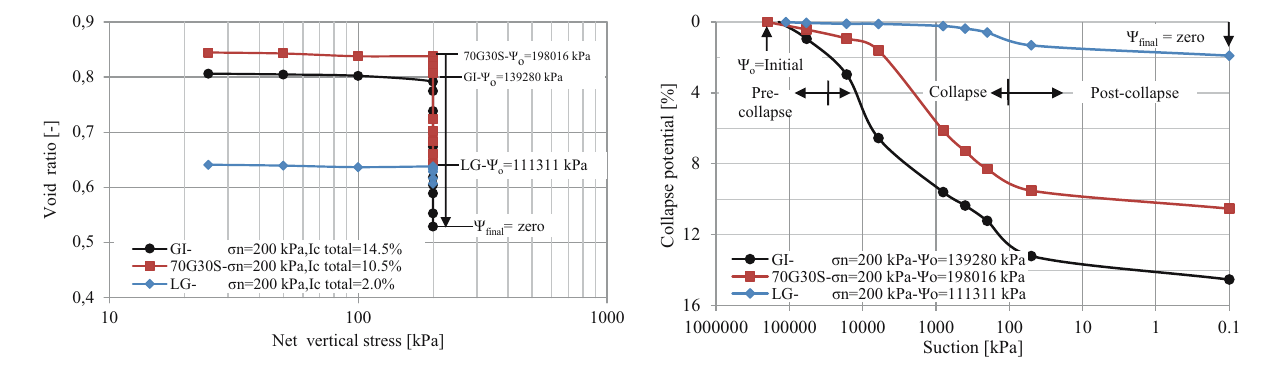
Figure 3: Variation of the void ratio with net vertical stress of the ( CN - SD ) wetting test.